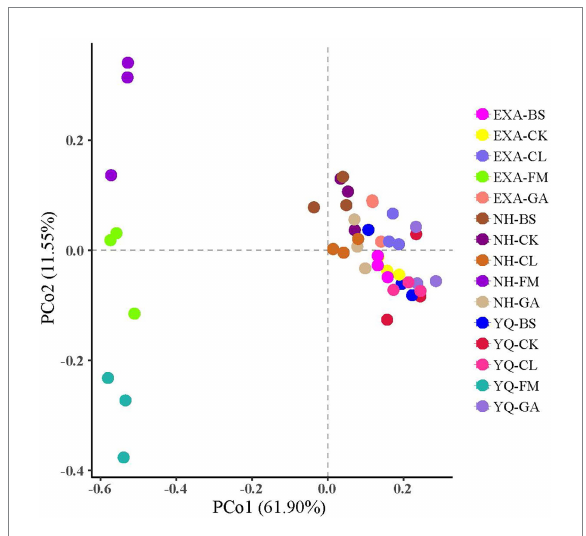
FIGURE 2 Principal component analysis (PCA) of bacterial communities for whole-plant corn silage with different treatmentsn. YQ, corn variety Yuqing 386; EXA, corn variety Enxiai 298; NH, corn variety Nonghe35; FM, fresh raw materials; CK, no additives; BS, 0.02% Bacillus subtilis CP7 of FM; GA, 0.2% gallic acid of FM; CL, 0.02% cellulase of FM.